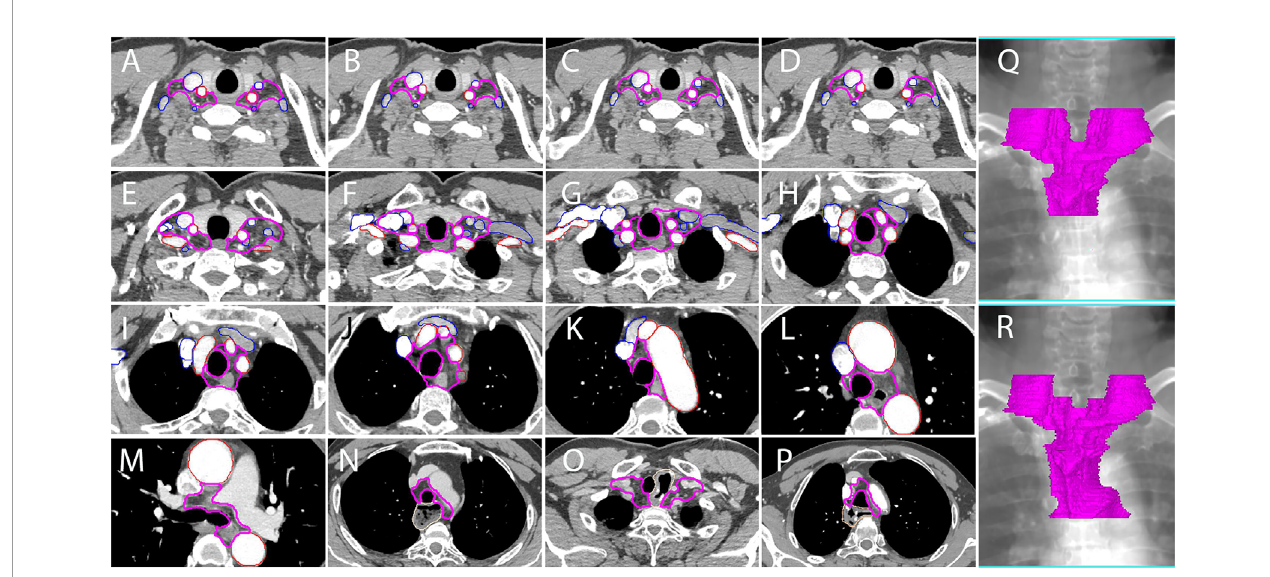
FIGURE 4 | A proposed delineation of CTVnd in lower neck and upper mediastinum for PORT of TESCC. Pink lines: CTVnd; red lines: arteries; blue lines: veins. (A, C) at the level of the cricothyroid membrane (upper TESCC); (B, D) at the level of the cricothyroid membrane (middle and lower TESCCs); (E) at the level of the upper margin of subclavian arteries; (F) at the level of the lower margin of the horizonal part of subclavian arteries; (G) at the level of the lower margin of thyroid; (H) at the level of the upper margin of innominate artery; (I) at the level when the innominate artery is closely contact with the trachea; (J) at the level of the upper margin of aortic arch; (K) at the level when the aortic arch is closely contact with the trachea; (L) at the level of the upper margin of azygos vein (middle and lower TESCCs); (M) the level of tracheal carina (middle and lower TESCCs); (N) stomach in posterior mediastinum; (O) anastomosis in the cervicothoracic junction; (P) anastomosis in the level of aortic arch; (Q) reconstructed CTVnd on the template CT for upper TESCC; (R) reconstructed CTVnd on the template CT for middle and lower